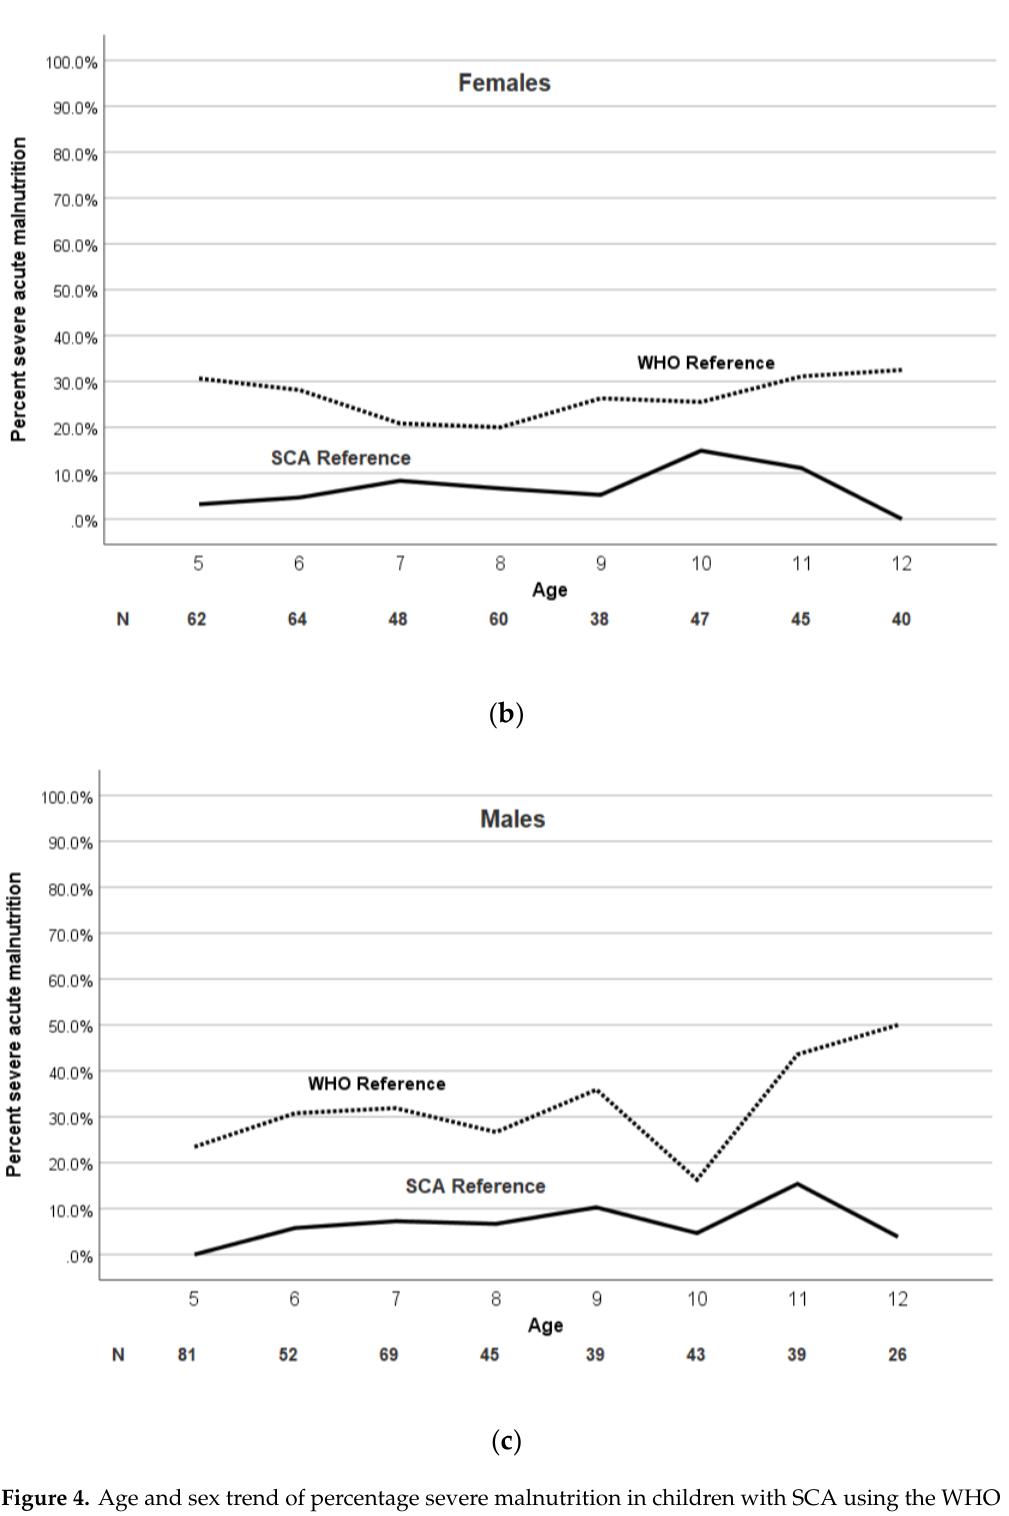
Figure 4. Age and sex trend of percentage severe malnutrition in children with SCA using the WHO and SCA reference populations. ( a ) The prevalence of severe malnutrition (BMI Z -score < − 3) in children with SCA is dependent on the growth reference used and is consistently greater at each age according to the WHO growth reference. ( b , c ) Age and sex trend of BMI Z -score in children with SCA using the WHO and SCA reference population. The prevalence of severe malnutrition (BMI Z -score < − 3) in both males and females with SCA is consistently greater at each age according to the WHO growth reference with an increase after age 10.